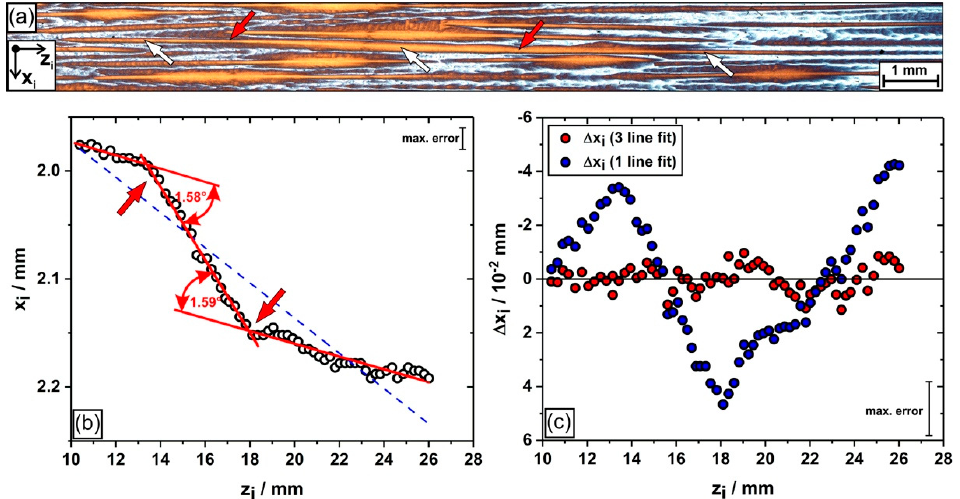
Figure 10. Experimental evidence for dendrite bending. Withdrawal rate: 45 mm/h. ( a ) Overview micrograph; for details, see text. ( b ) Higher magnification image of the rectangular region in Figure 10a. The small crosses represent data points where dendrite coordinates were determined. ( c ) Growth paths of the three dendrites marked in Figure 10a. ( d ) Deviation from linearity of dendrite growth paths.